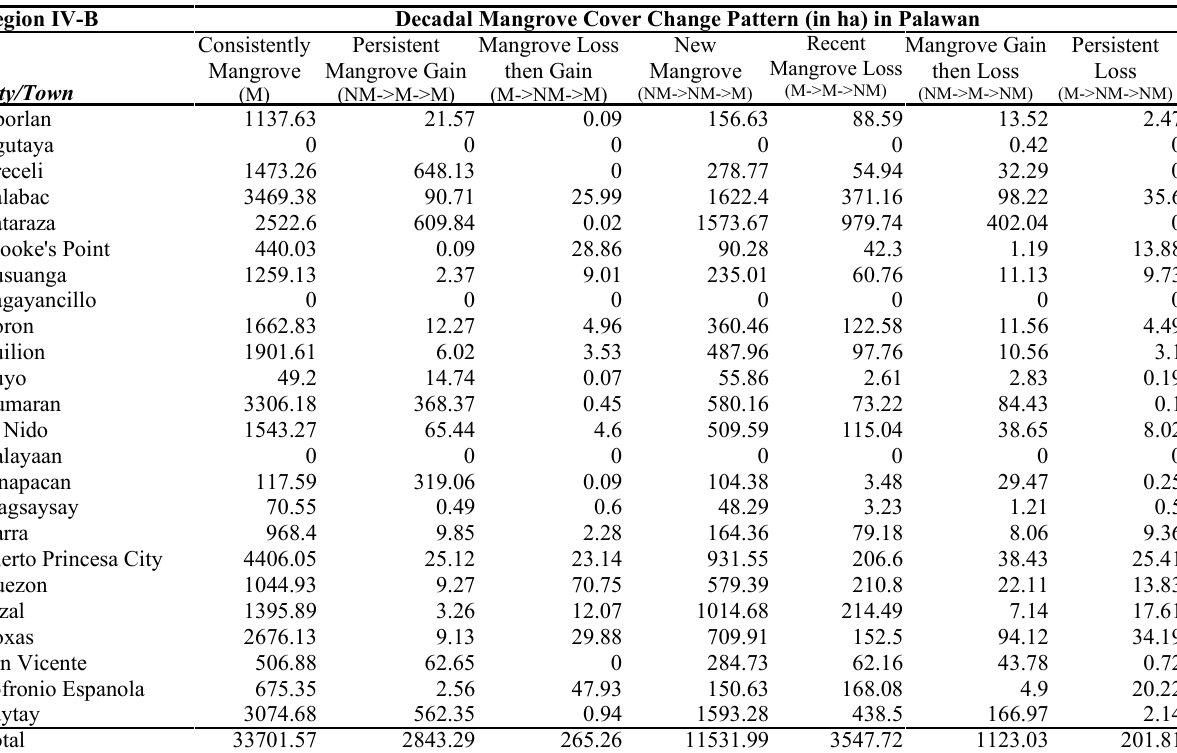
Table 10. Decadal Mangrove cover change pattern (in ha) in Palawan. Note: M symbolizes the existence of mangroves, NM